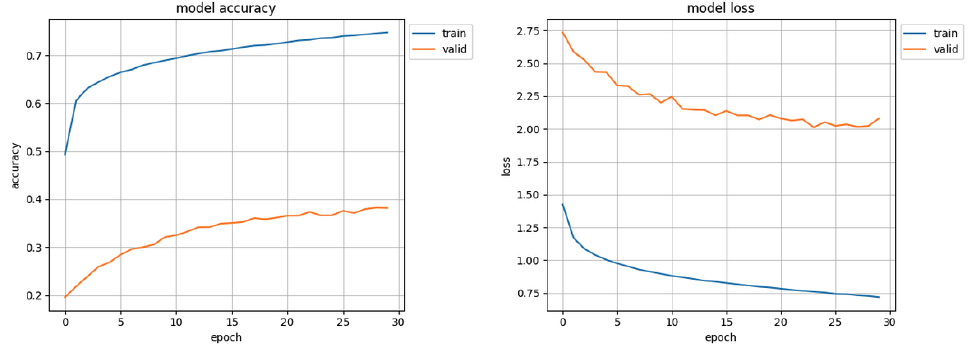
Figure 8. Initial training results, with correct validation